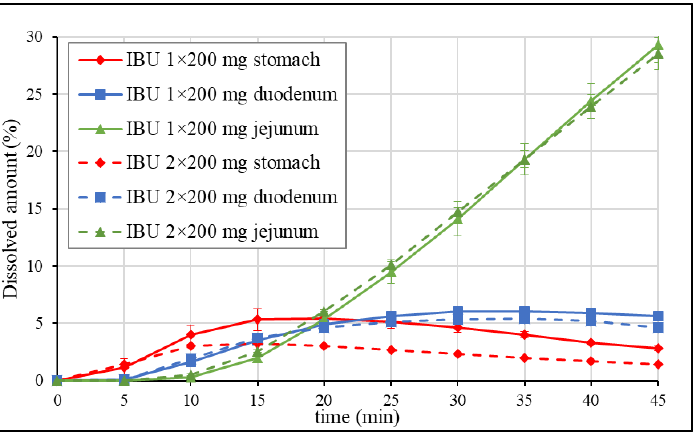
Figure 4. GIS dissolution results of IBU 1 × 200 mg vs. 2 × 200 mg tablets in blank biorelevant media.